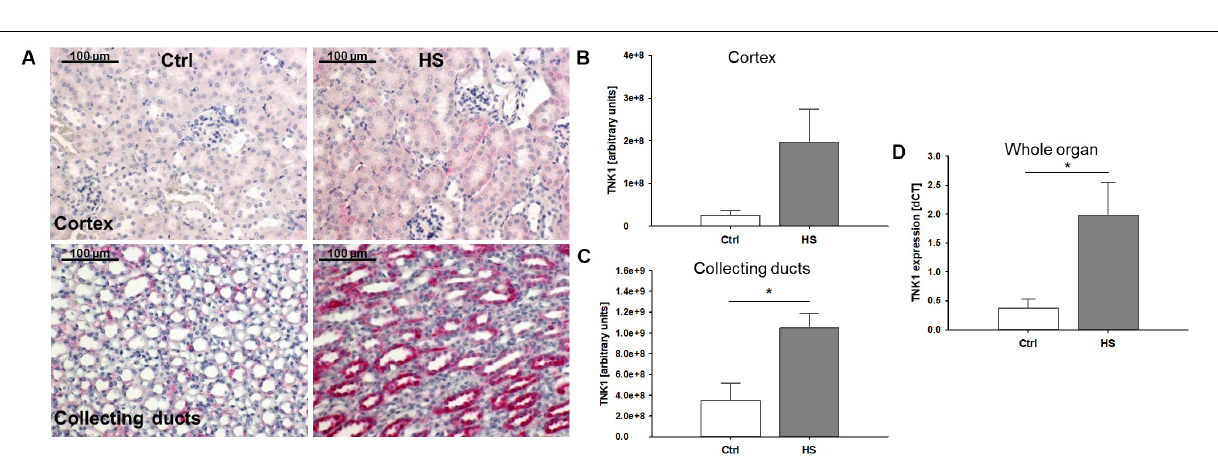
FIGURE 3 | Non-receptor tyrosine-protein kinase 1 (TNK1) expression in murine kidneys after HS. TNK1 expression in kidneys of control (Ctrl) mice and animals after hemorrhagic shock (HS) was assessed by immunohistochemical staining and semiquantitative analysis. While there was only a modest increase in TNK1 expression (stained in red; nuclei were counterstained with hematoxylin) in the renal cortex (A,B) , expression was significantly higher in collecting ducts of animals after HS (A,C) compared to controls. Quantitative real-time PCR revealed a significant increase in TNK1 mRNA in whole tissue lysates (D) . * p < 0.05; n = 4 Ctrl, and n = 4 HS for (B,C) ; n = 4 Ctrl, n = 7 HS for (D)